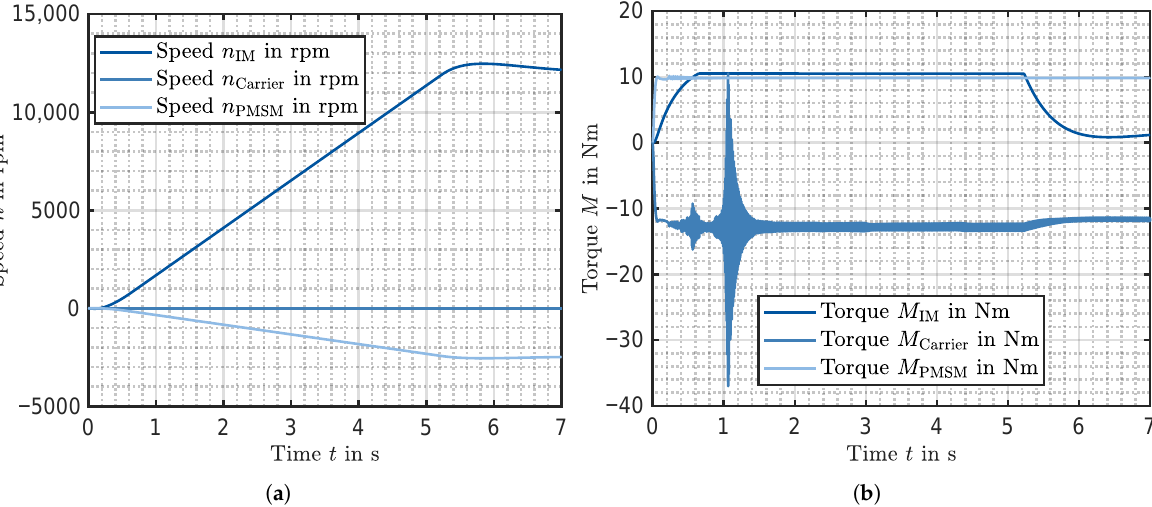
Figure 10. Results of the transient system model using the developed force element: ( a ) Speeds of the different shafts; ( b ) Reaction torques of the different shafts.